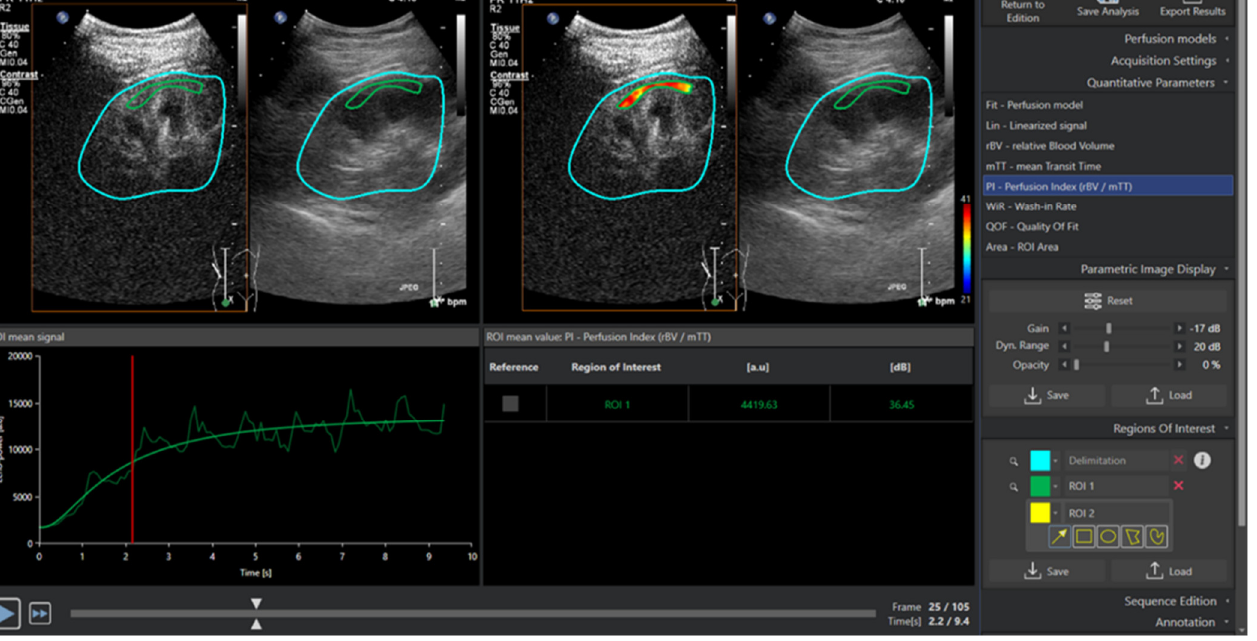
Figure 1. A quadrant view from the quantification software showing the drawn ROI around the renal cortex. renal